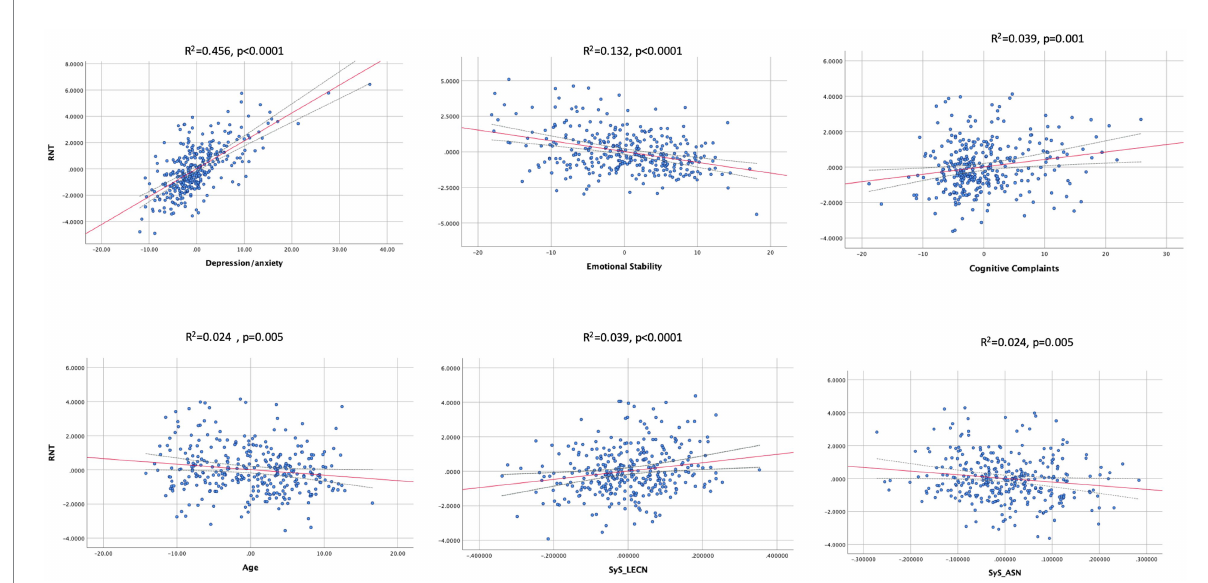
FIGURE 1 Partial regression plots showing associations between all retained variables and RNT (Repetitive Negative Thinking). Dashed lines indicate the 99% confidence intervals for the regression line. SyS, system segregation; LECN, left executive control network; ASN, Anterior Salience